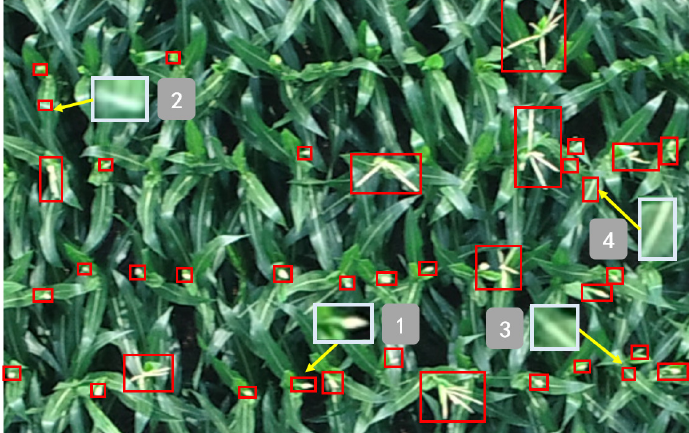
Figure 12. Detailed diagram of detection results. Red boxes represent automatically detection by proposed method, (1) the newly grown tassels; (2) reflective leaf was misidentified as tassel; (3) and (4) leaves vein were misidentified as